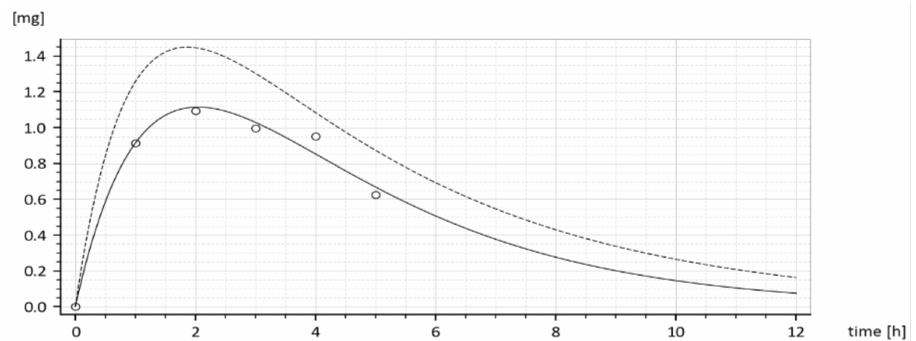
Figure 7. The in-vivo measured drug amounts x 2 (t) without the added tenside (full curve) and the model predicted amounts with the tenside (dashed